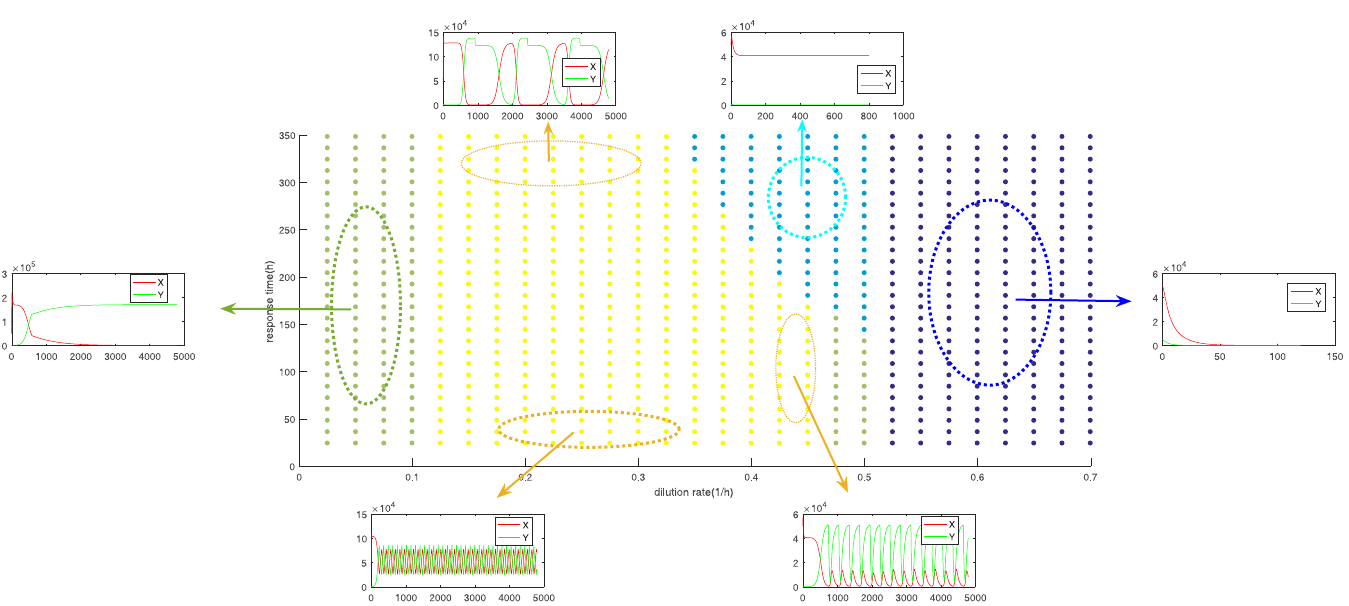
Fig 3. Parameter space behaviour of the discrete model for varying values of the dilution rate and response time. Different colours correspond to different steady states with extinction of population y and steady state for x (light blue), extinction of x and steady state for y (light green) and finally coexistence through oscillations